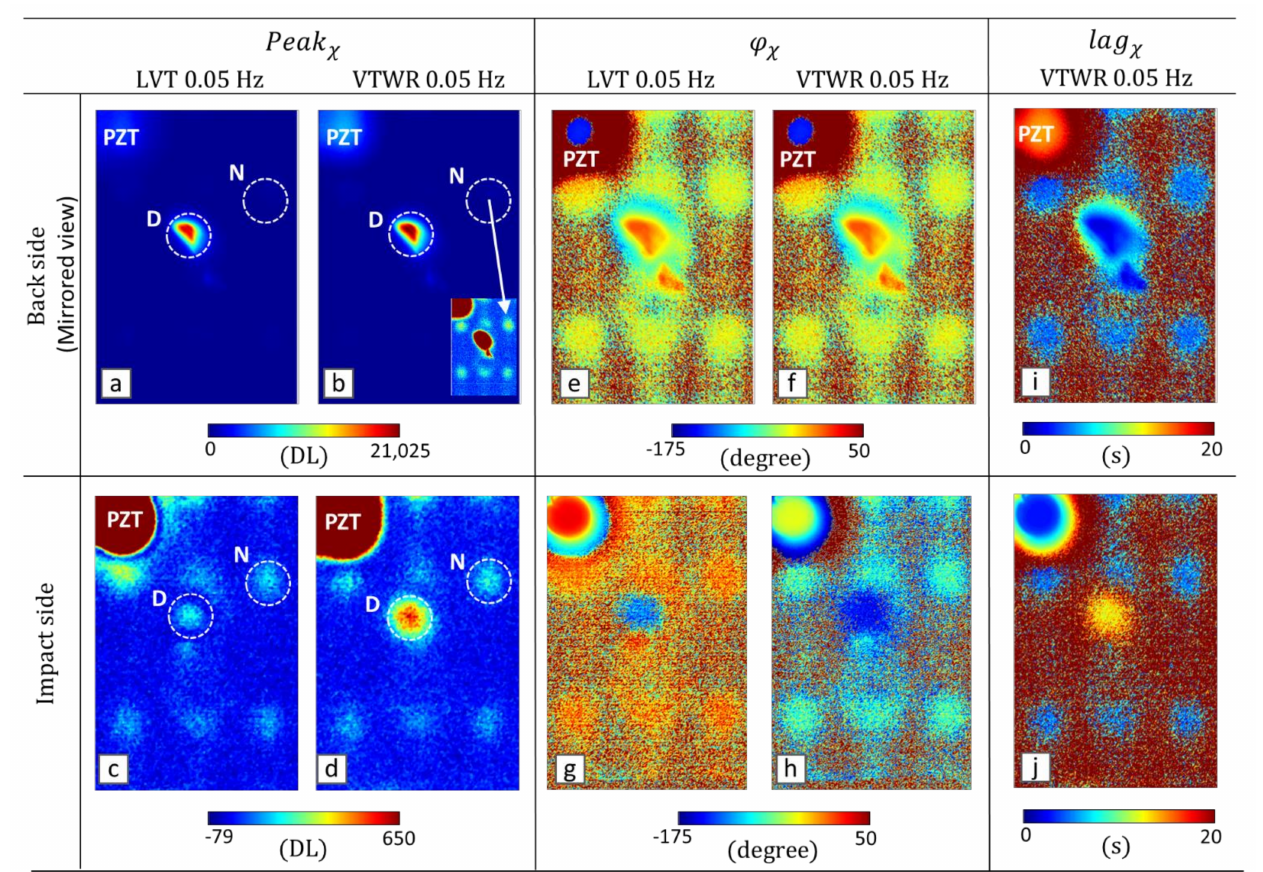
Figure 5. Vibrothermographic inspection of the CFRP sample at LDR frequency 91.3 kHz and AM frequency 0.05 Hz through LVT and VTWR from backside (top row) and impact side (bottom row): ( a – d ) Peak χ ( e – h ) ϕ χ and ( i – j ) lag χ . Note that the area heated by the PZT wafer is saturated in ( c , d